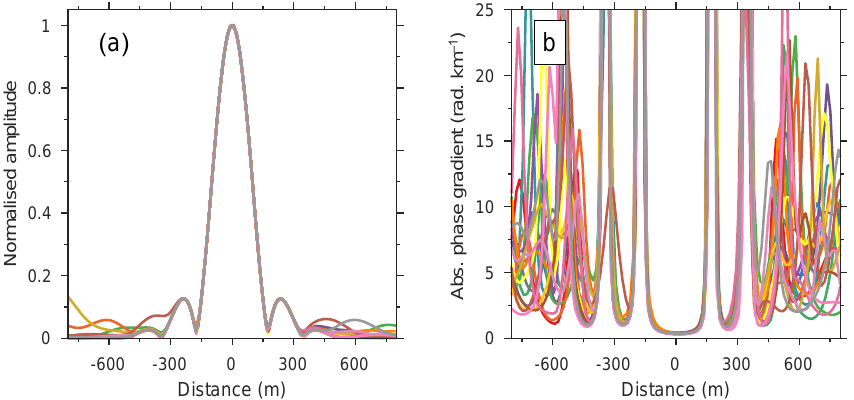
Figure 5. Impact of 20 wind turbines on weather radar I/Q data, recorded by Vara during September 2016. Panel (a) shows the average normalised amplitudes of the wind turbine echoes, while panel (b) shows the corresponding average absolute phase gradient